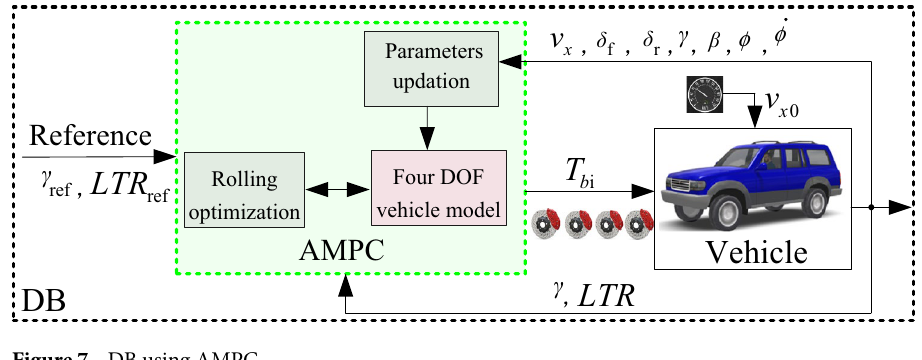
Figure 7. DB using